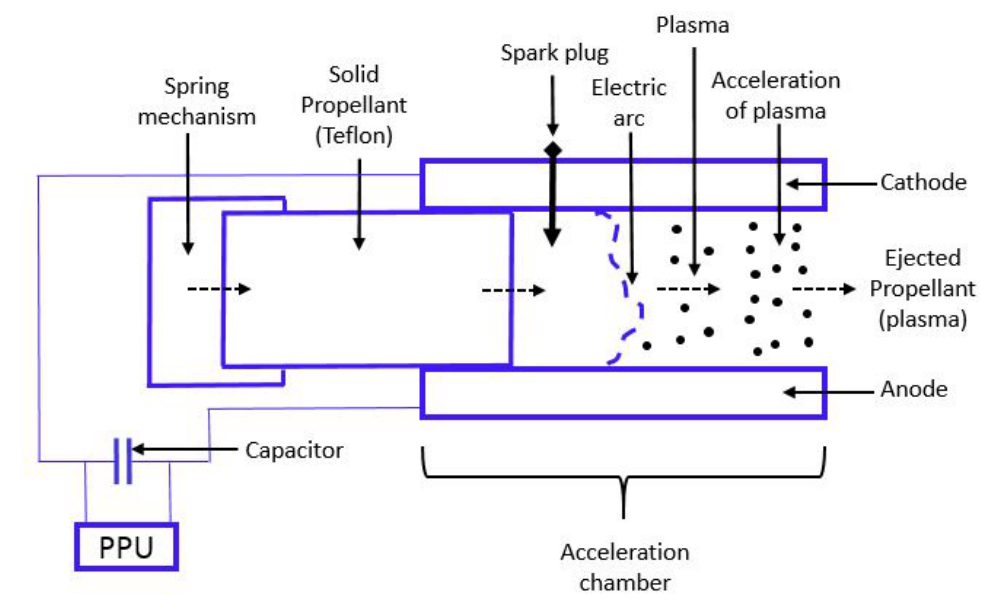
Figure 8. Schematic of a Pulse Plasma